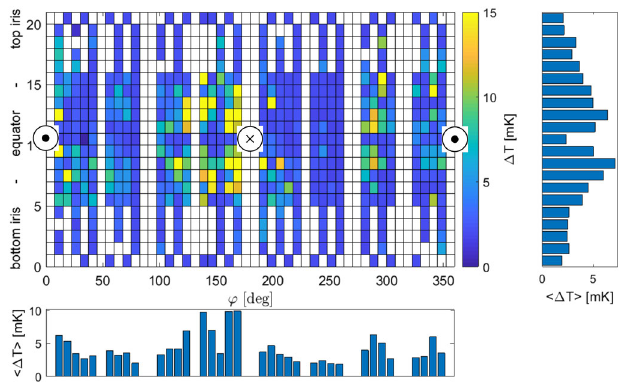
FIG. 10. Relative heating for applied field in φ ¼ 0 °, α ¼ 0 °. It is indicated where the magnetic field is perpendicular to the cavity ’ s surface. The data is recorded at 1.8 K, and E ¼ 15 MW = m. The quality factor is Q acc